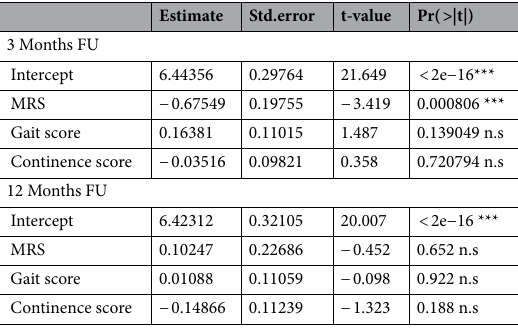
Table 5. Multivariate linear regression.